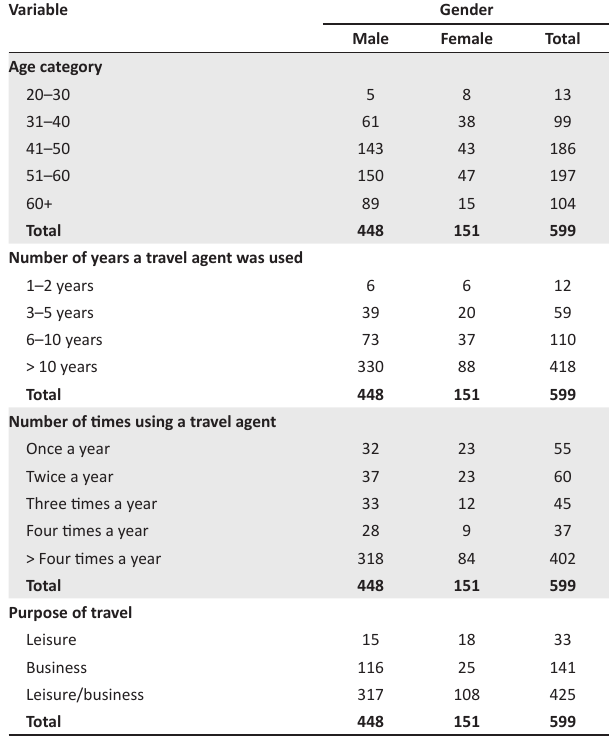
TABLE 1: Particulars of the respondents.